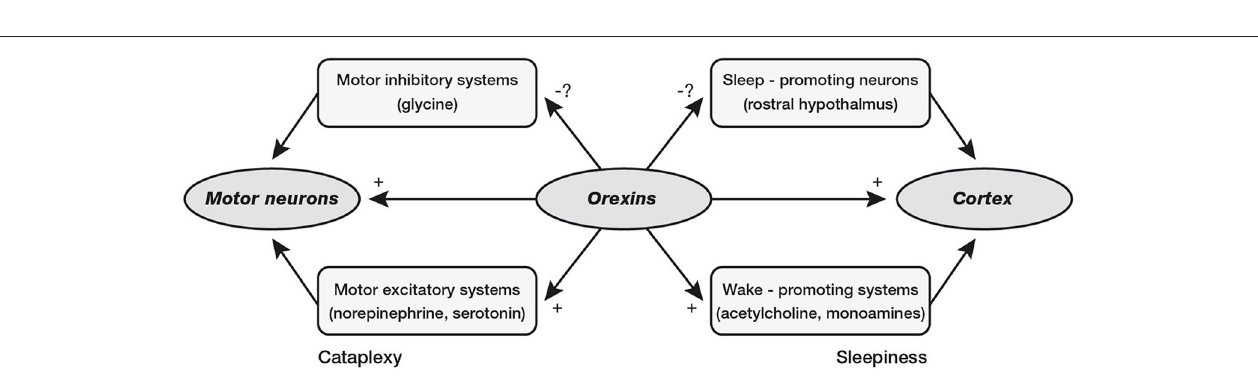
FIGURE 2 | Schematic drawing showing main projections of orexin neurons. This figure summarizes predicted orexinergic projections in the human brain. Please note that distributions of orexin fibers and receptors (OX 1 R, OX 2 R) are predicted from the results of studies on rodent brains since most histological studies on the orexin system have been carried out in mice and rats. Circles show regions with strong receptor expression and dense orexinergic projections. Orexin neurons originating in the lateral hypothalamic area (LHA) and posterior hypothalamus (PH) regulate sleep and wakefulness and the maintenance of arousal by sending excitatory projections to the entire CNS, excluding the cerebellum, with particularly dense projections to monoaminergic, and cholinergic nuclei in the brain stem and hypothalamic regions including the locus coeruleus (LC, containing noradrenaline), tuberomammillary nucleus (TMN, containing histamine), raphe nuclei (Raphe, containing serotonin), and laterodorsal/pedunclopontine tegmental nuclei (LDT/PPT), containing acetylcholine). Orexin neurons also have links with the reward system through the ventral tegmental area (VTA, containing dopamine) and with the hypothalamic nuclei that stimulate feeding behavior.